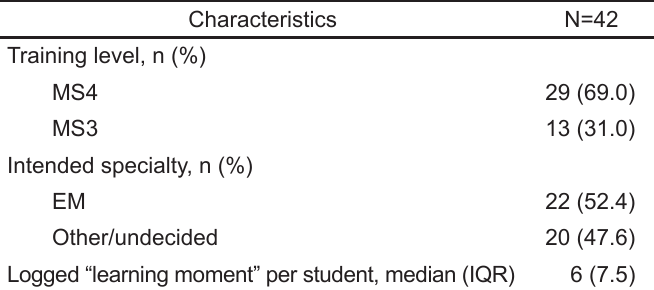
Table 1. Characteristics of medical students who participated in Learning